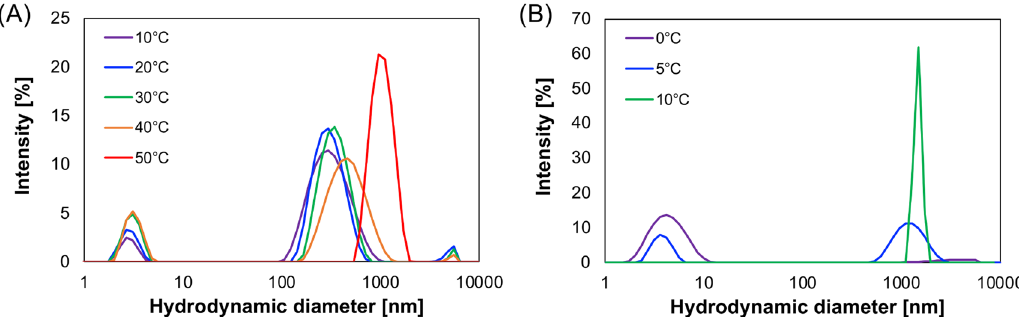
Figure 6. Particle size distribution of AADAAC-F4 at various temperatures. The size distribution of the coacervates formed in the AADAAC-F4 aqueous solution were analyzed by DLS. ( A ) AADAAC-F4 was dissolved in Tris–HCl buffer solution (50.0 mM Tris, 599 mM NaCl, pH 8.0). The peptide concentration was 4.26 mM. Under this condition, the T t value for AADAAC-F4 was 45.2 °C. ( B ) AADAAC-F4 was dissolved in the same Tris–HCl buffer containing equimolar amount of CdCl 2 . Under this condition, the T t value for AADAAC-F4 was 2.2